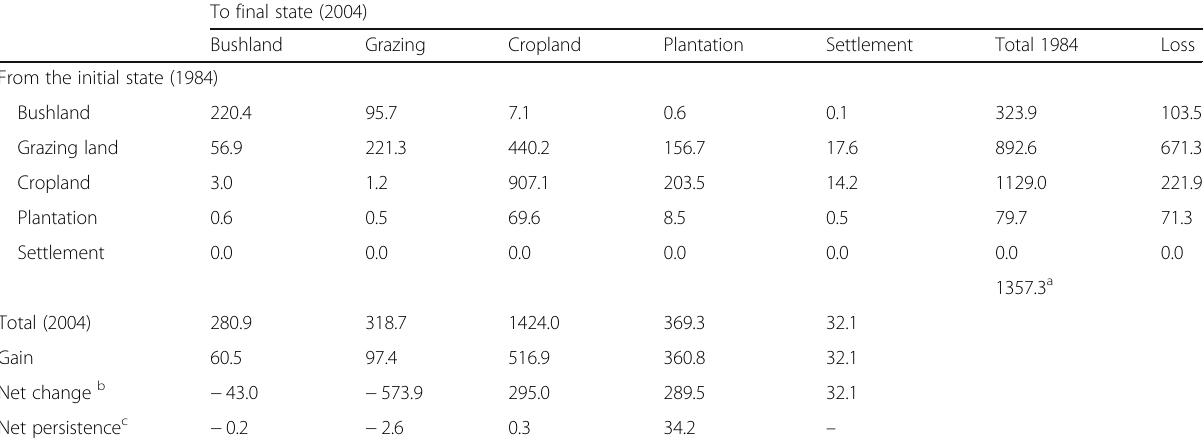
Table 5 LULC transition matrix of major changes in the landscape from 1984 to 2004 (%) To final state